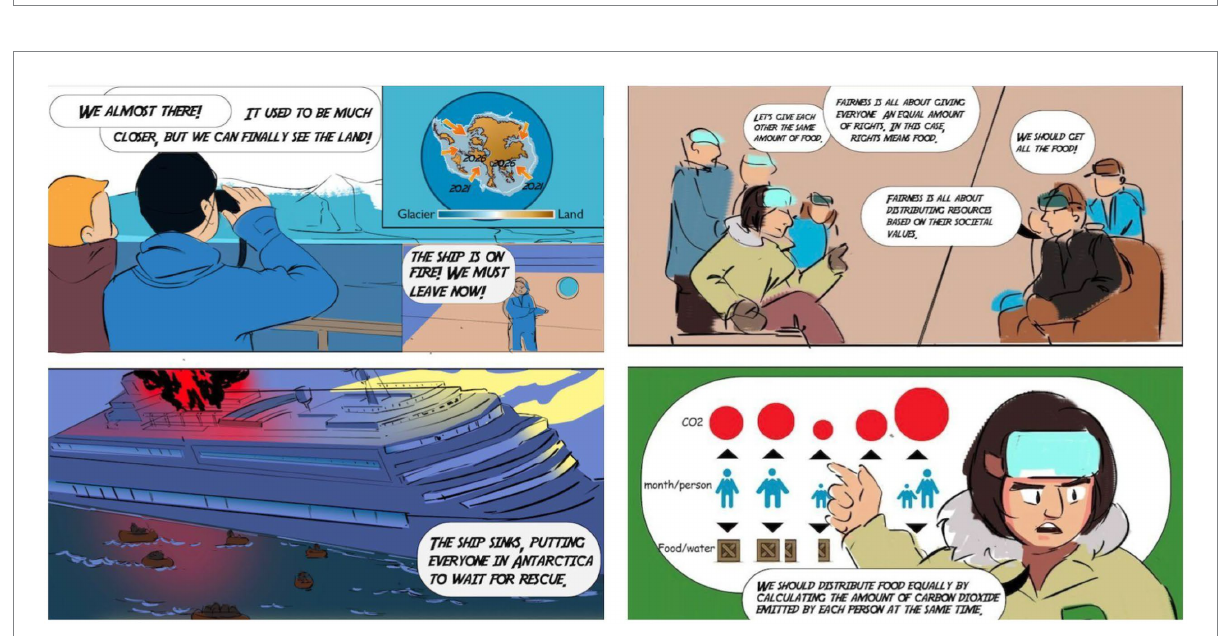
FIGURE 4 Using data visuals in New Revolia to describe strategies for sharing carbon emission